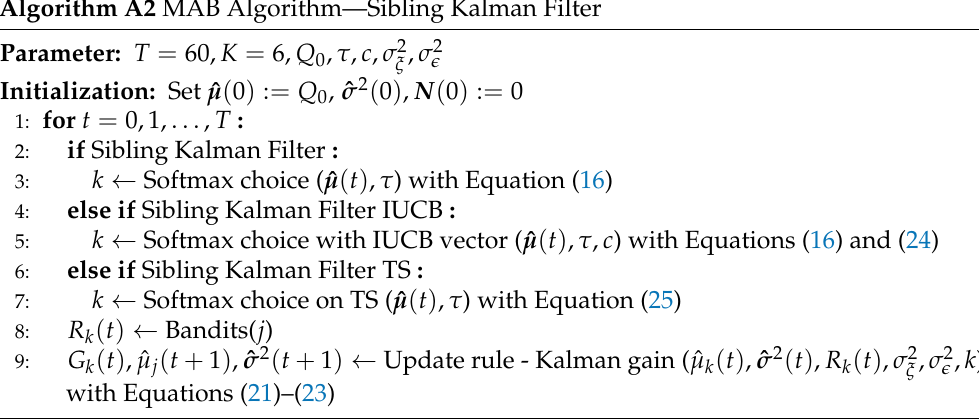
Algorithm A2 MAB Algorithm—Sibling Kalman